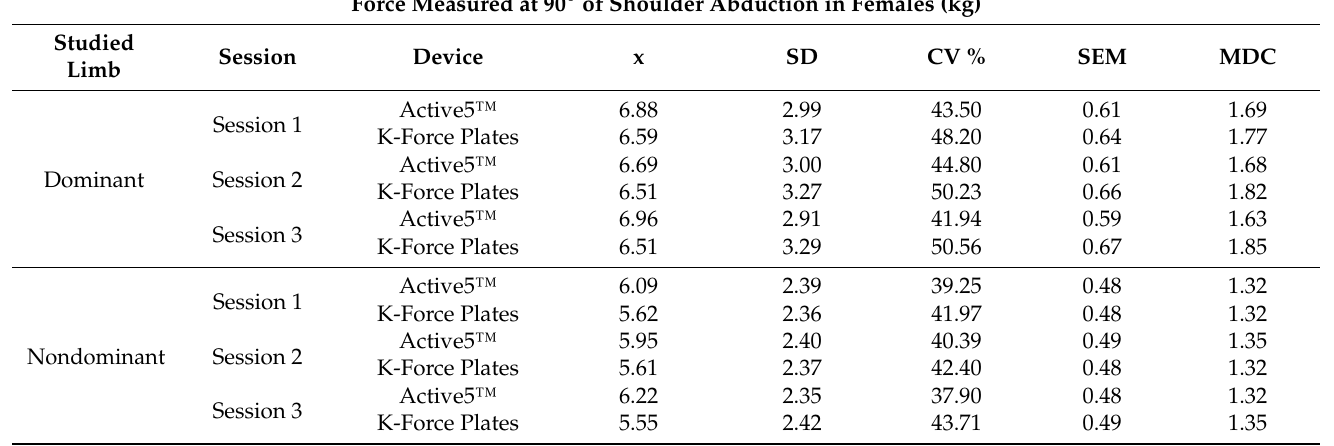
Table 8. The results of force measurements at 90 ◦ shoulder abduction using Active5™ and K-Force Plates in the female group.